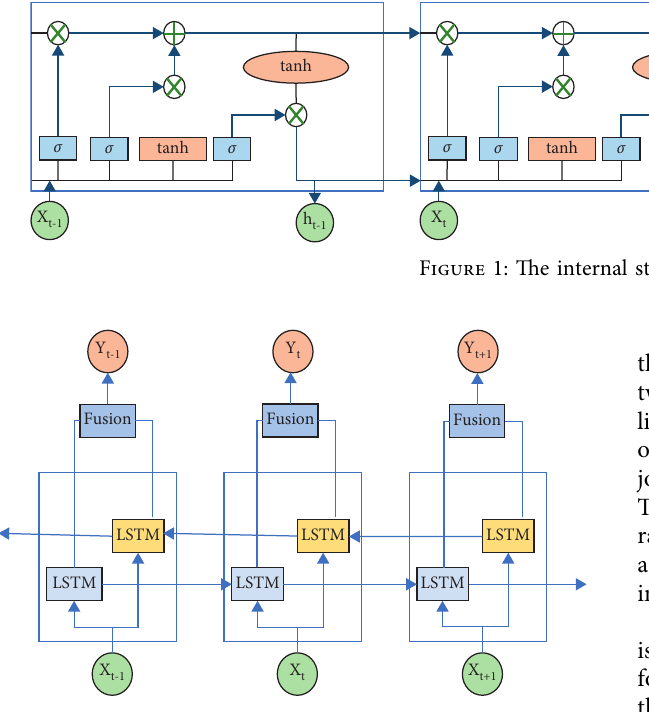
Figure 2: Structure of